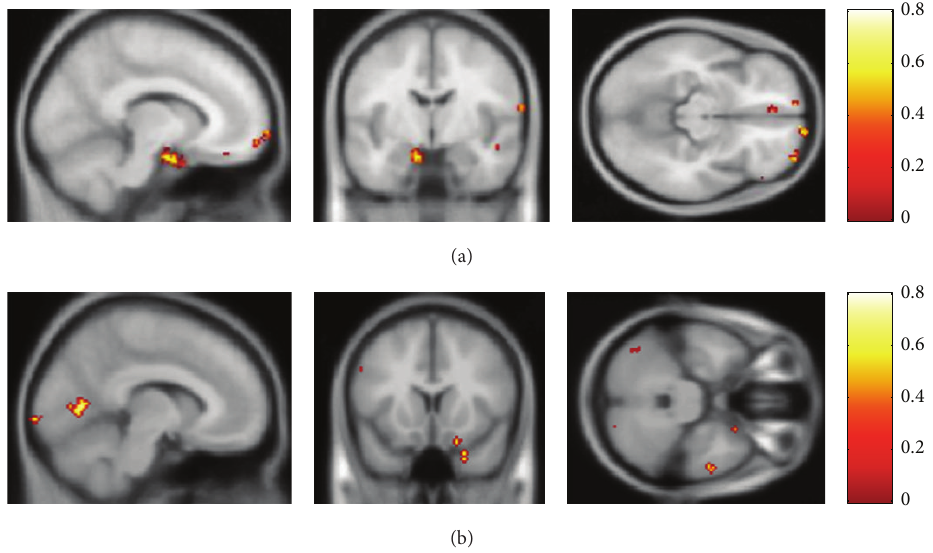
Figure 5: Searchlight results for the explicit encoding condition (a) and fast mapping condition (b) across